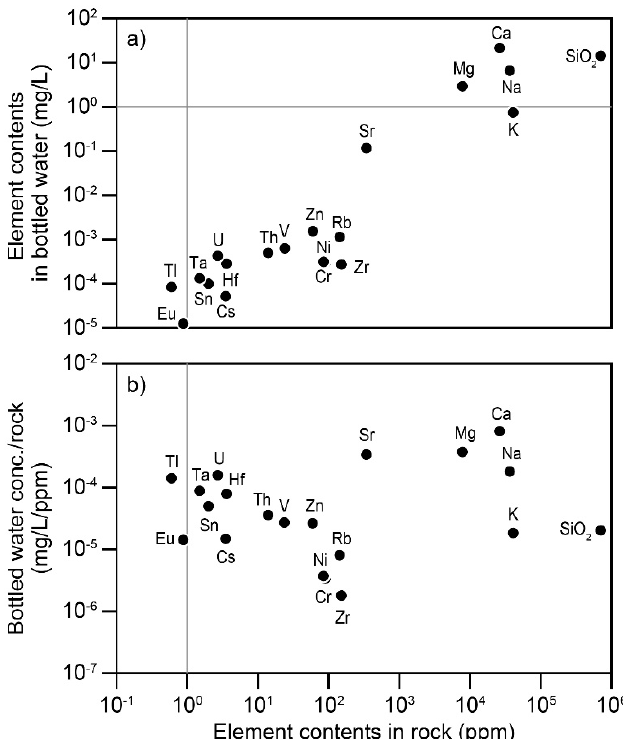
Figure 5. Comparison of median concentrations of 20 chemical components of South Korean granitoids ( n = 31) [32] and Ca-HCO 3 -type bottled water ( n = 33). ( a ) rock to bottled water and ( b ) rock to bottled water/rock ratio.